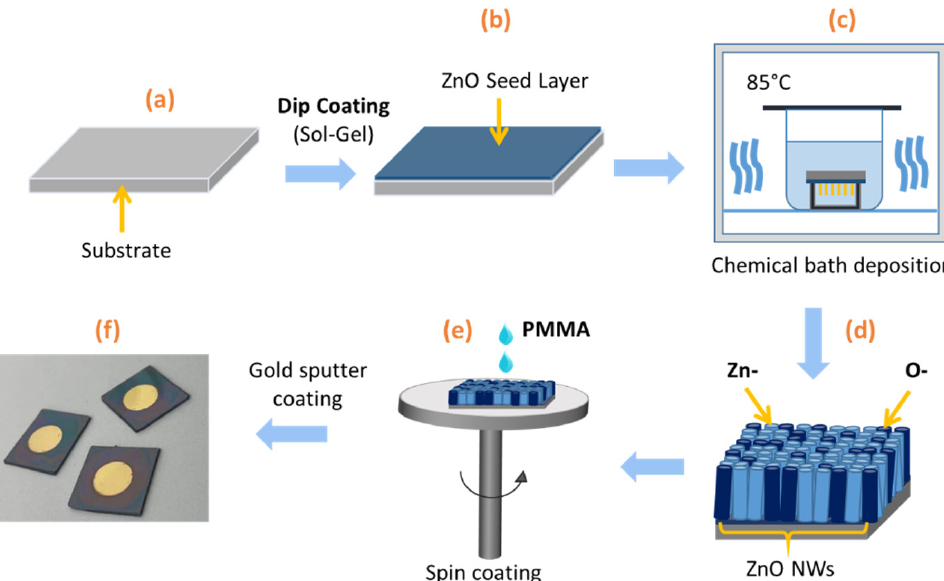
Figure 2. Fabrication steps of ZnO NW arrays/PMMA composite : ( a ) Preparation of Si substrate; ( b ) Deposition of ZnO seed layer (SL); ( c ) Growth of ZnO NWs through chemical bath deposition (CBD); ( d ) Representation of different polarities of ZnO NWs; ( e ) Incorporation of PMMA dielectric polymer; ( f ) Final sample coated with circular gold electrodes.